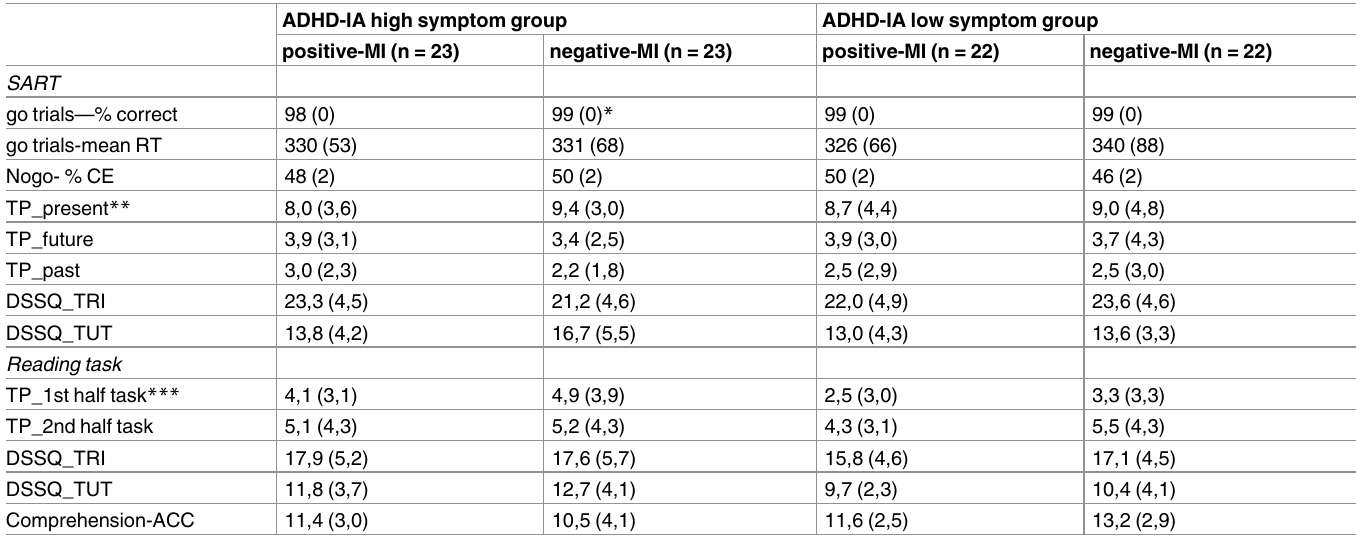
Table 2. Mean scores (and SD’s between brackets) for all dependent variables in the SART and reading tasks in the two attention groups and posi- tive and negative mood induction (MI) conditions. ADHD-IA high symptom group ADHD-IA low symptom